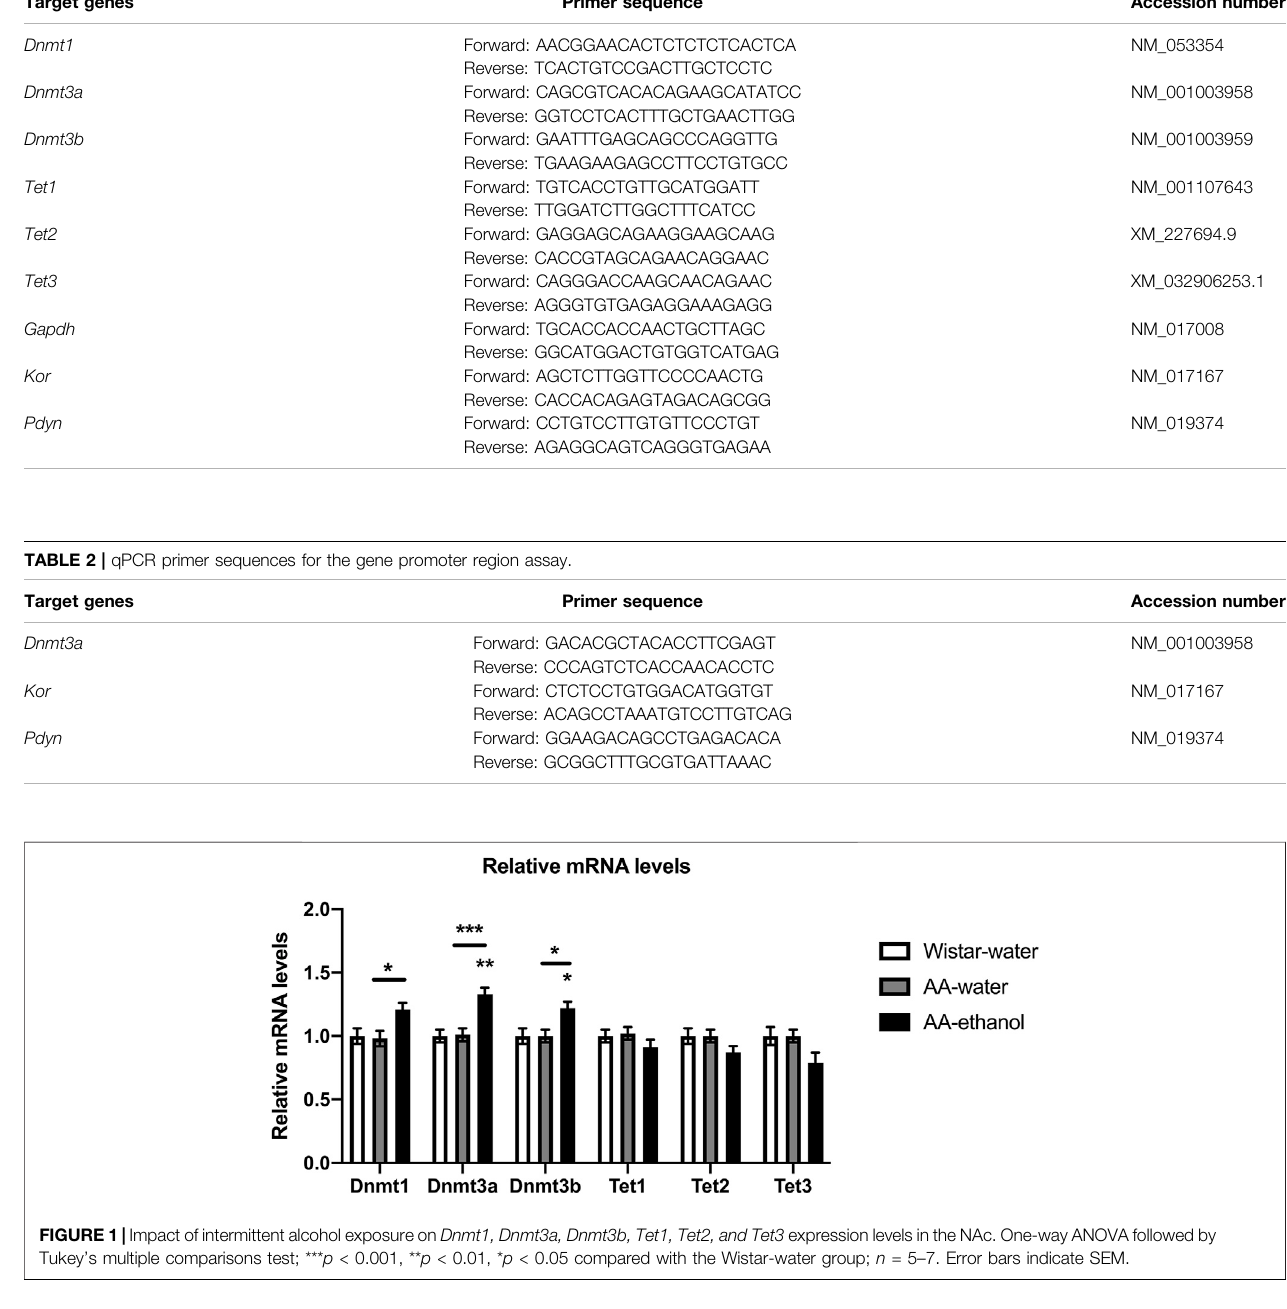
Frontiers in Genetics |